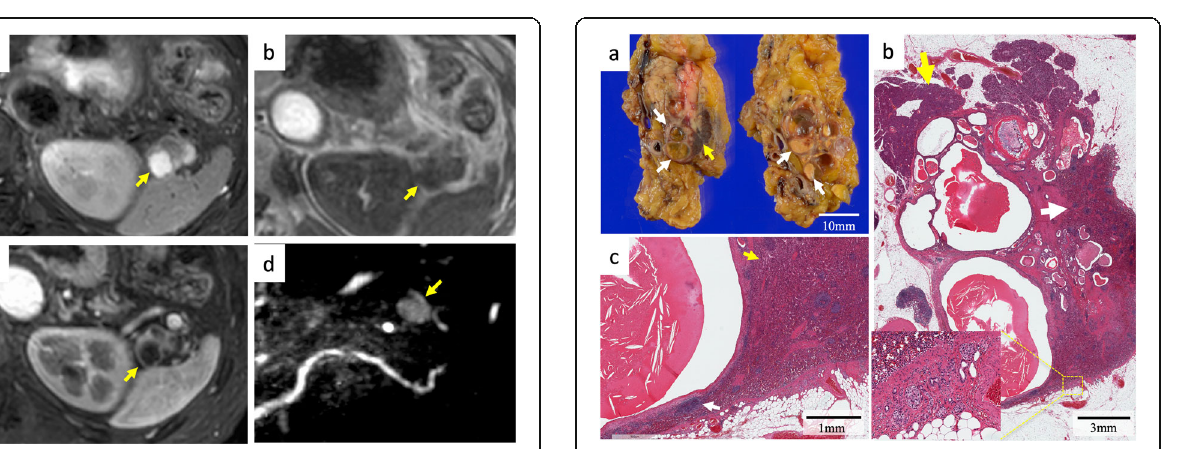
Fig. 2 Magnetic resonance images. a Cystic components show varying intensities on T2-weighted images (yellow arrow). b Cystic components exhibit low intensity on T1-weighted images (yellow arrow). c Cystic wall is enhanced on contrast-enhanced magnetic resonance imaging (yellow arrow). d Magnetic resonance cholangiopancreatography showing that there is no indication to suggest a connection between the pancreatic lesion and the main pancreatic duct